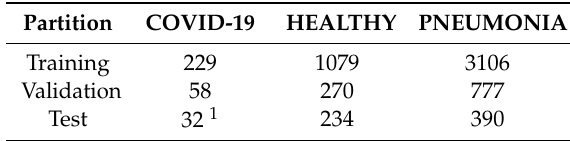
Table 3. Number of examples per